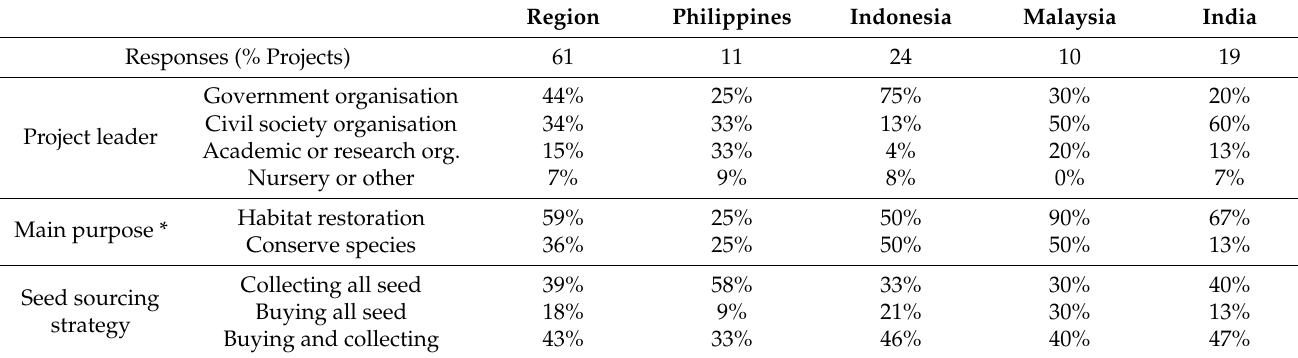
Table 4. Characteristics for surveyed forest landscape restoration projects by country.